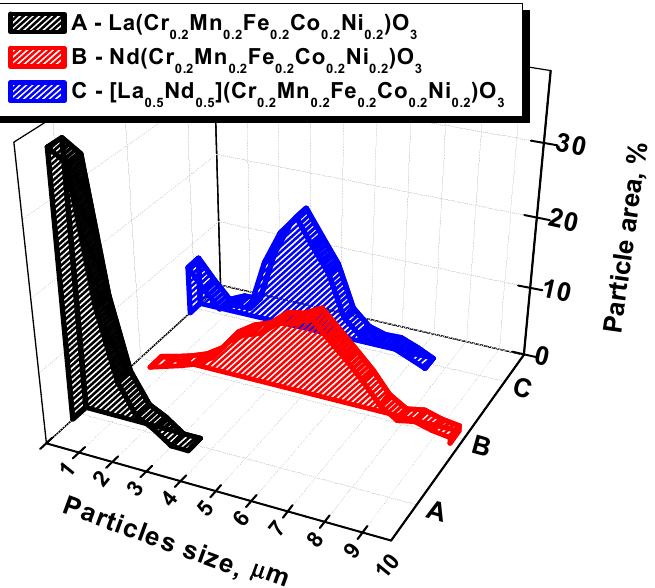
Figure 3. Particles’ size distribution of La-CMFCNO, Nd-CMFCNO and LN-CMFCNO ceramic samples.